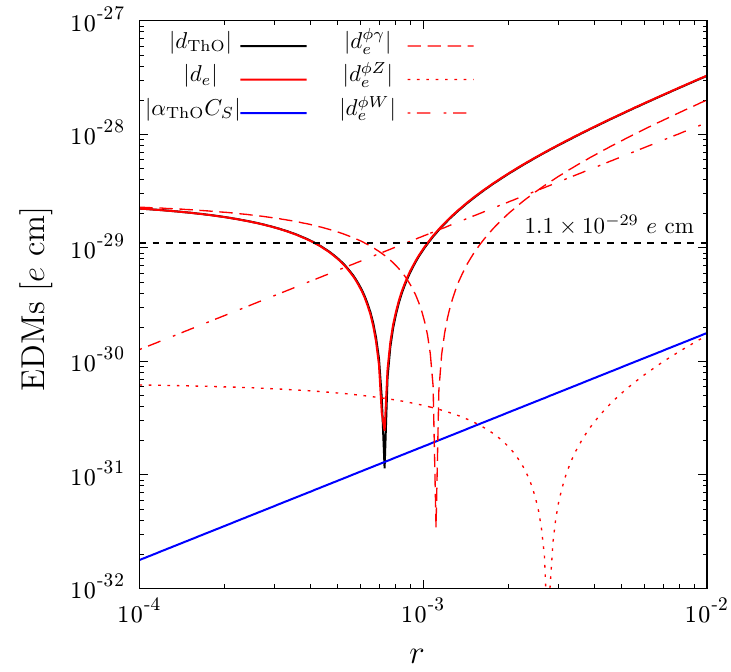
Figure 4 . Details of EDMs as functions of r . We take BP a for the Higgs spectrum and set c γ = 0 . 1 , Re ( ρ bb ) = 0 , Im ( ρ bb ) = − 0 . 15 and ρ tt = 0 . 5 as an example of the ρ bb -EWBG scenario. Other ρ